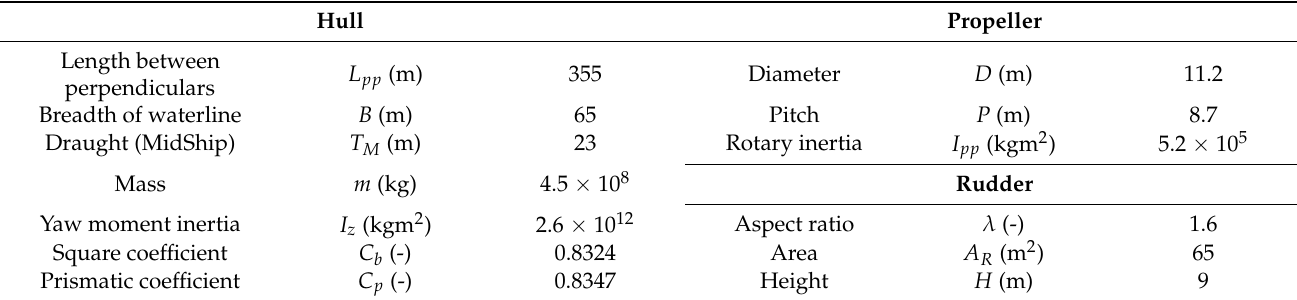
Table 1. Main parameters of the hull, propeller and rudder.